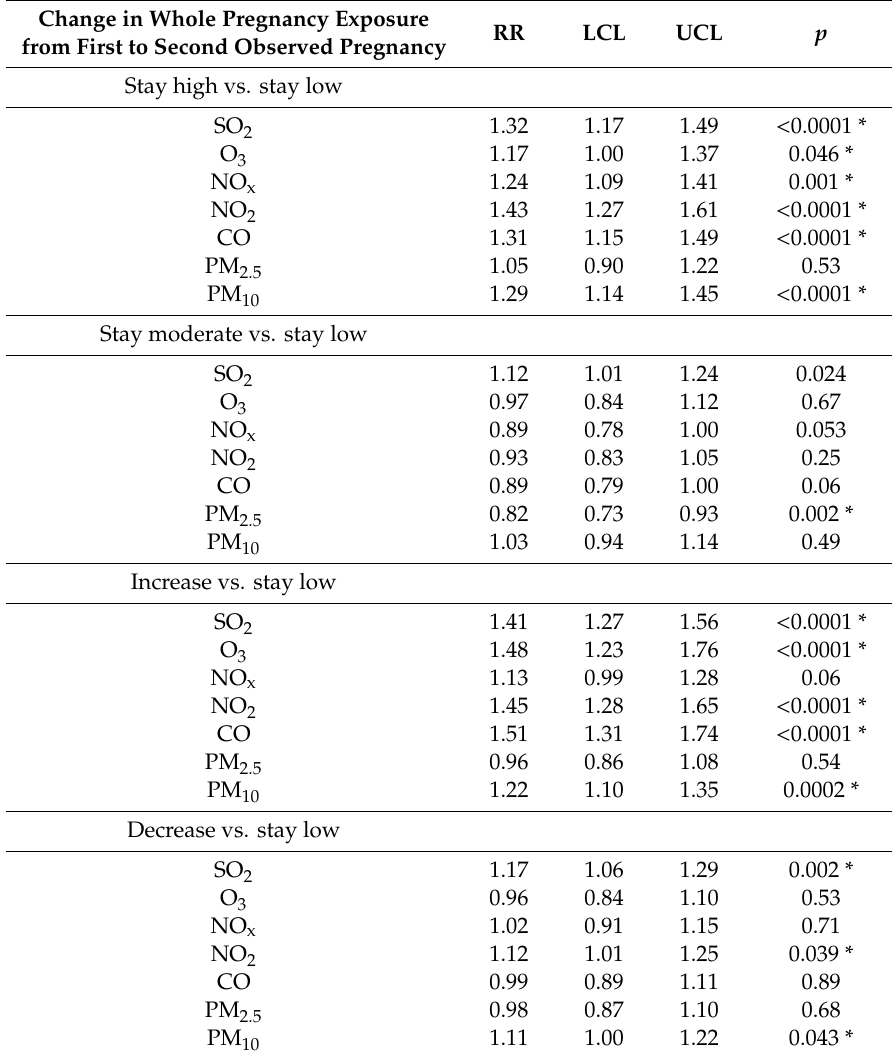
Table 2. The adjusted relative risk of preterm birth in second pregnancy by change in whole pregnancy average criteria pollutant exposure levels from first to second pregnancy among 50,005 mothers, NICHD Consecutive Pregnancy Study, 2002–2010. Second Pregnancy Preterm Birth Change in Whole Pregnancy Exposure from First to Second Observed